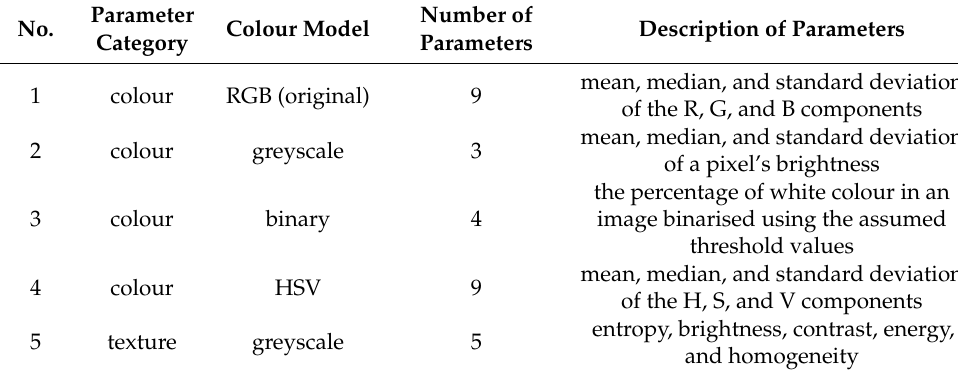
Table 2. Colour and texture parameters extracted from the images.